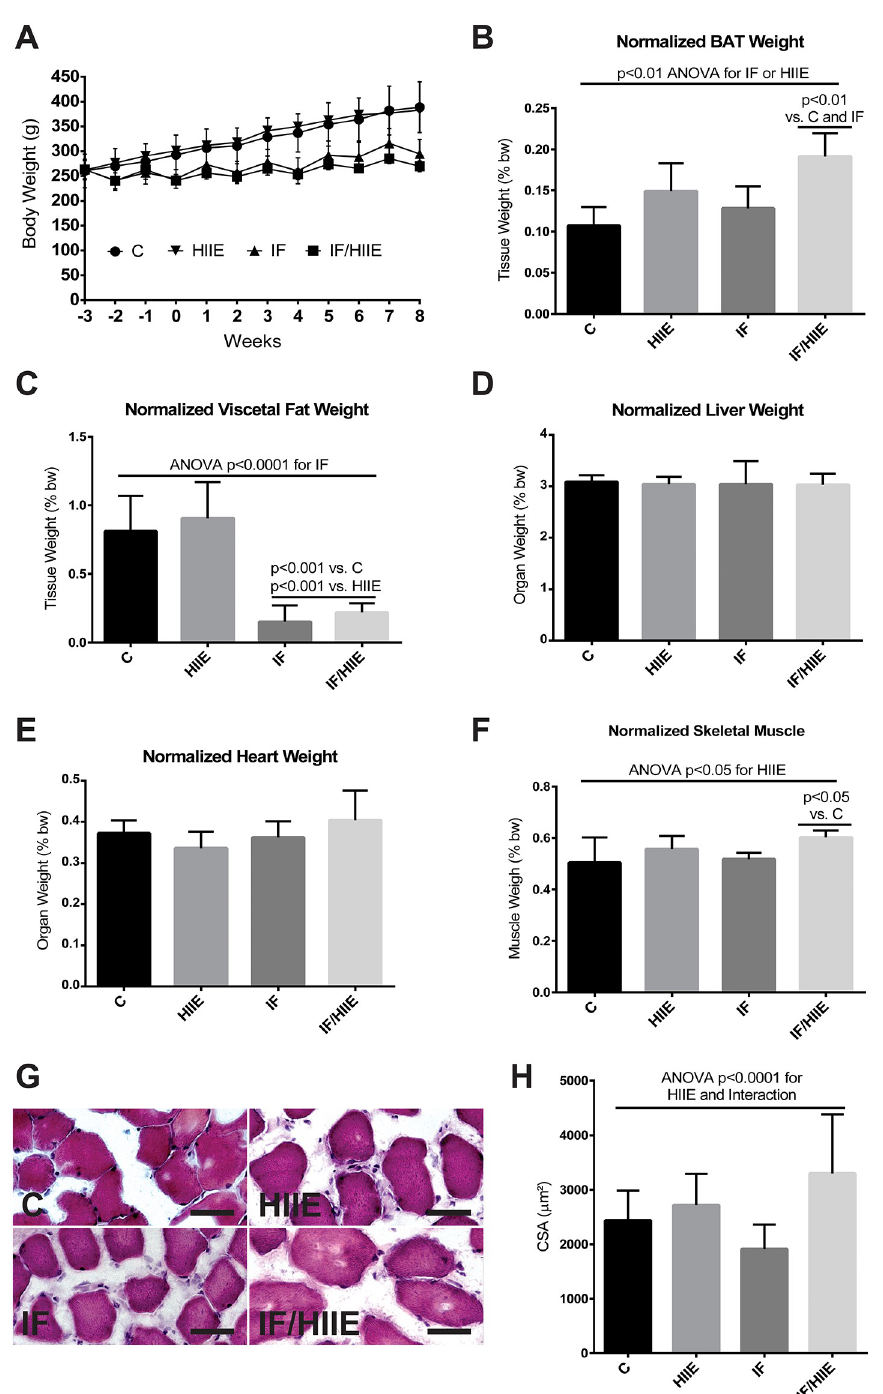
Fig 2. IF/HIIE prevents weight gain and adiposity and increases skeletal muscle cross-sectional area. (A) The bw curve from the weight weekly obtained in the morning before the withdrawal or reintroduction of food. Tissues and organs were collected from animals 2 days after day 56, the end of the study period, and immediately weighed. (B) normalized brown adipose tissue weight; (C) normalized visceral fat weight; (D) normalized liver weight (intact organ); (E) normalized heart weight (intact organ); (F) normalized skeletal muscle weight (gastrocnemius); (G) cross-sectional area histological profile (myofibers were stained with HE; 50 μ m bar) and (H) quantification (columns with mean values and SD bars of 150 myofibers per animal (n = 3) per group). All tissue weights are normalized by the last bw measured before euthanasia. Each bar represents the mean ± SD; A-F) n = 6; H) n = 3. Individual effects (IF and HIIE) and the effect of their interaction were verified by two-way ANOVA and multiple comparisons; p values were annotated.